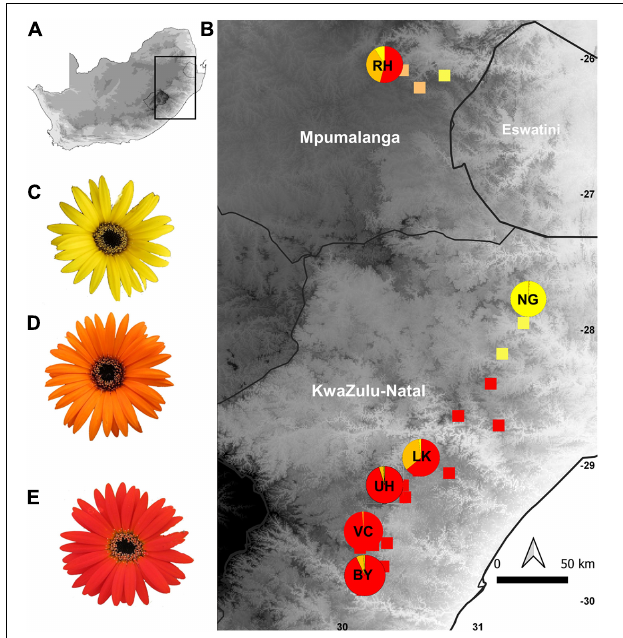
FIGURE 1 | Map showing the geographic distribution of capitulum color morphs in populations of Gerbera aurantiaca along its latitudinal range. (A) Map of South Africa; (B) color forms of G. aurantiaca in eastern South Africa; (C) G. aurantiaca yellow capitulum; (D) G. aurantiaca orange capitulum; (E) G. aurantiaca red capitulum. BY, VC, UH, LK, NG, and RH are the six study populations selected and the pie charts indicate the capitulum color proportions of these